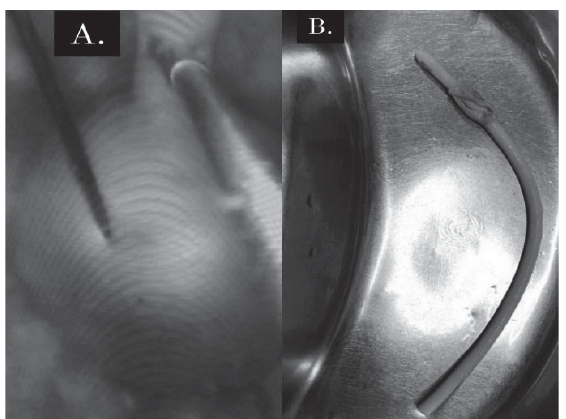
Figure 1. Cystoscopic guided suprapubic puncture of balloon (A); Foley’s catheter with punctured balloon (B).